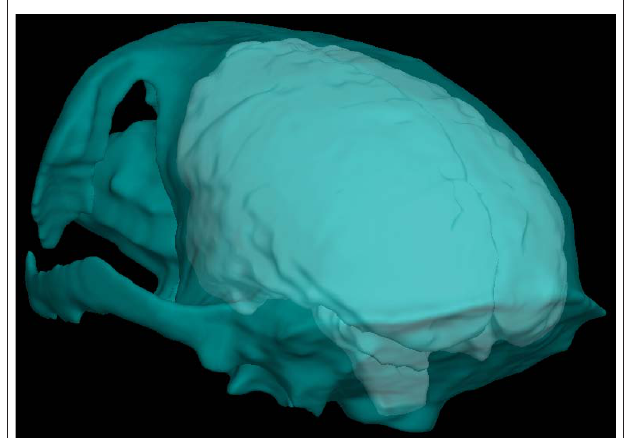
Figure 1 | Surface information that has been extracted from the Mri. Looking through the outer skull surface (cyan) one can see the outer brain surface